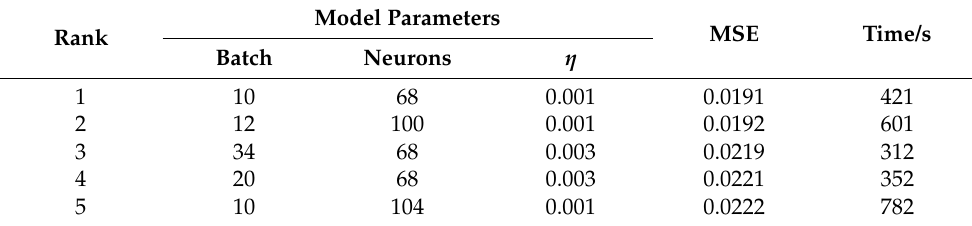
Table 1. Number of batches and neurons, and training